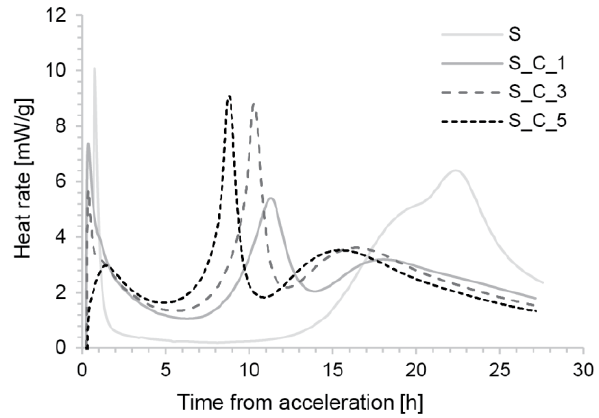
Figure 7. Hydration kinetics of the S mix accelerated with Sika Rapid C100.